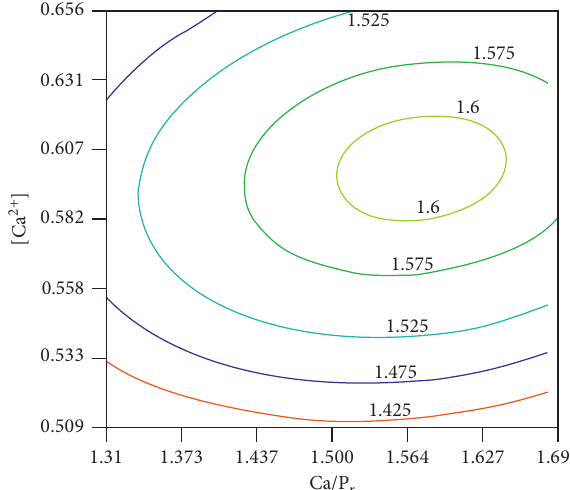
Figure 1: Isoresponse contour plot for Ca/P with pH � 7.87, T � 40 ° C, and D � 1h.